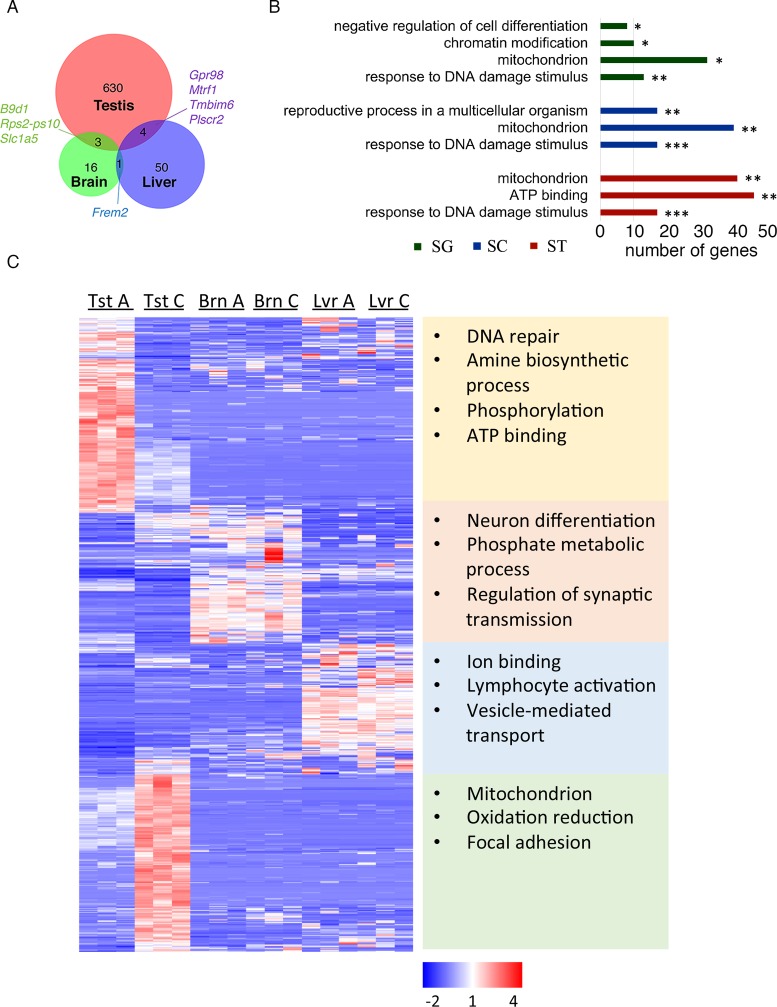
Embryonic exposure to ATZ globally affects gene expression in the third generation of males after treatment. (A) Venn diagram of the DEGs in ATZ F3 male testes, liver and brain. (B) The functional annotation of DEGs in testis fractions reveals several enriched clusters; gene ontology terms are sorted based on P-values (*P < 0.05; **P < 0.01, ***P < 0.001, Fisher exact test), SG-spermatogonia, SC-spermatocytes, ST-spermatids. The number of genes in each term is shown in right. (C) The heatmap of the expression of DEGs in the testes. The hierarchical cluster analysis groups the DEGs from the testes into four clusters according to their expression levels in three tissues. The corresponding enriched GO terms for each cluster are shown in the right. Each column represents a biological replicate. The upregulated genes are depicted in red, downregulated in blue. TstC (testis control samples), TstA (testis ATZ samples), BrnC (brain control samples), BrnA (brain ATZ samples), LvrC (liver control samples) and LvrA (liver ATZ samples).